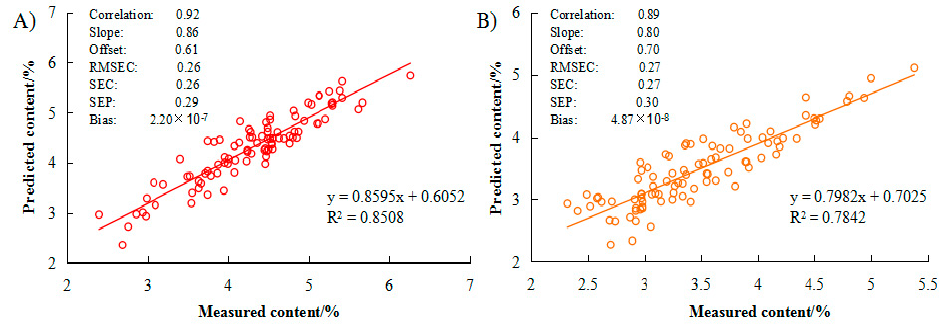
Figure 5. Scatter plots of measured versus predicted moisture content of: ( A ) Camellia gauchowensis Chang; and ( B ) C. semiserrata Chi kernels for the PLS models by NIRS.